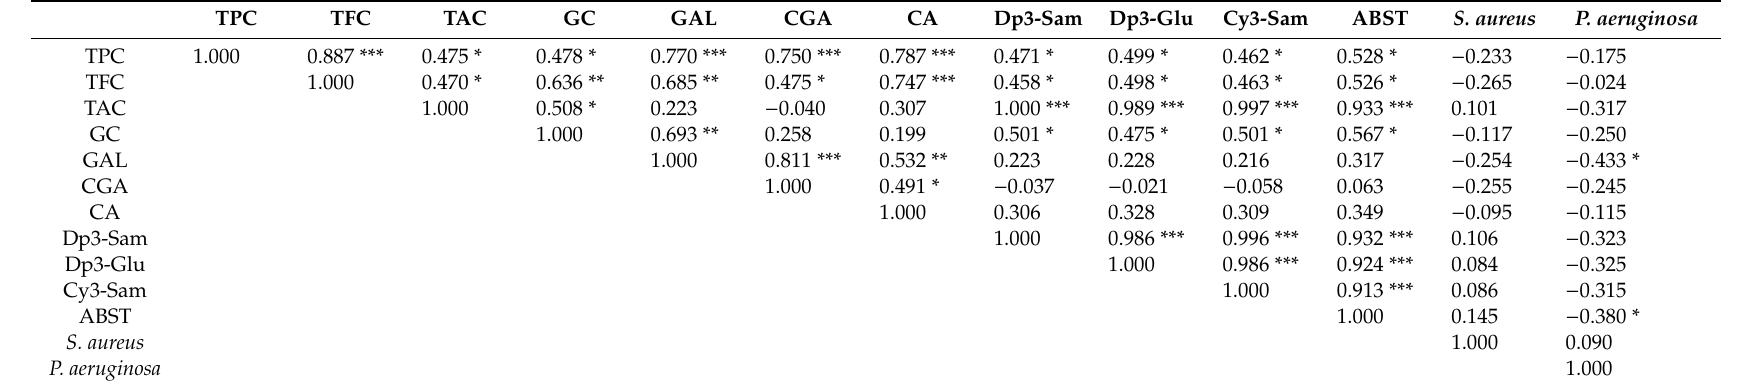
Table 4. Correlation coe ffi cients between the contents of phenolic compounds and antioxidant / bacterial